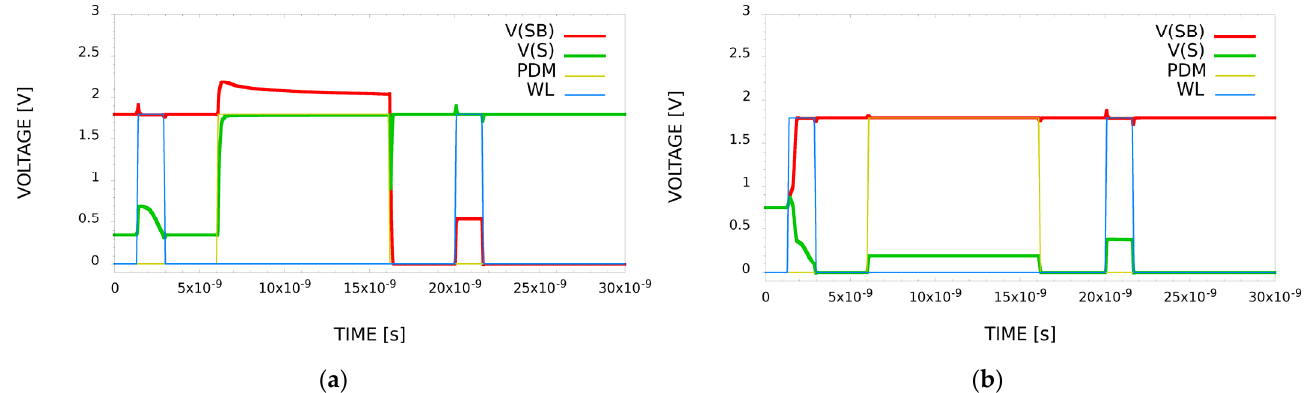
Figure 5. ( a ) Simulation of an LPR test with a bit-flip due to R1; ( b ) simulation of an LPR test without defects.